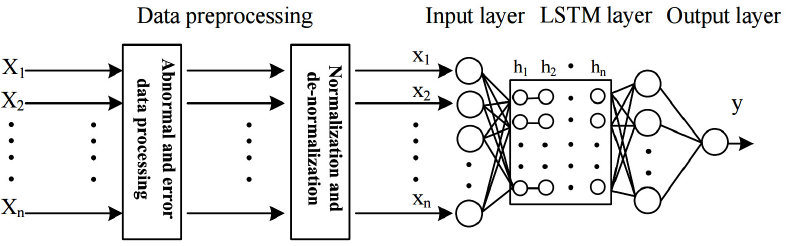
Figure 6. Modeling process of the intelligent model.